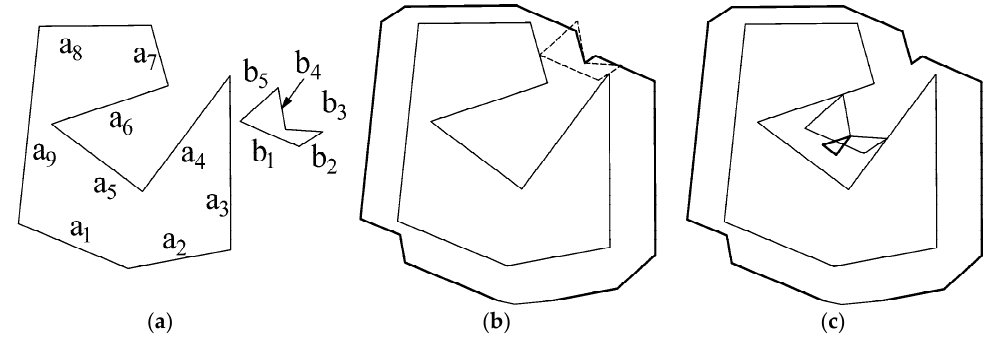
Figure 11. An example of interlocking concavities: ( a ) Polygons A and B ; ( b ) NFP produced by first stage; ( c ) complete NFP.